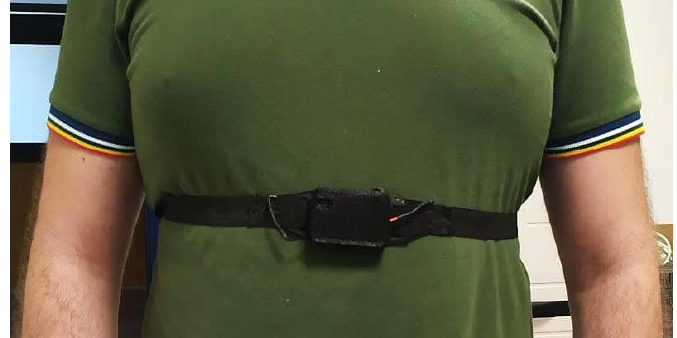
Figure 8. Breathing rate sensor worn on the user’s chest.